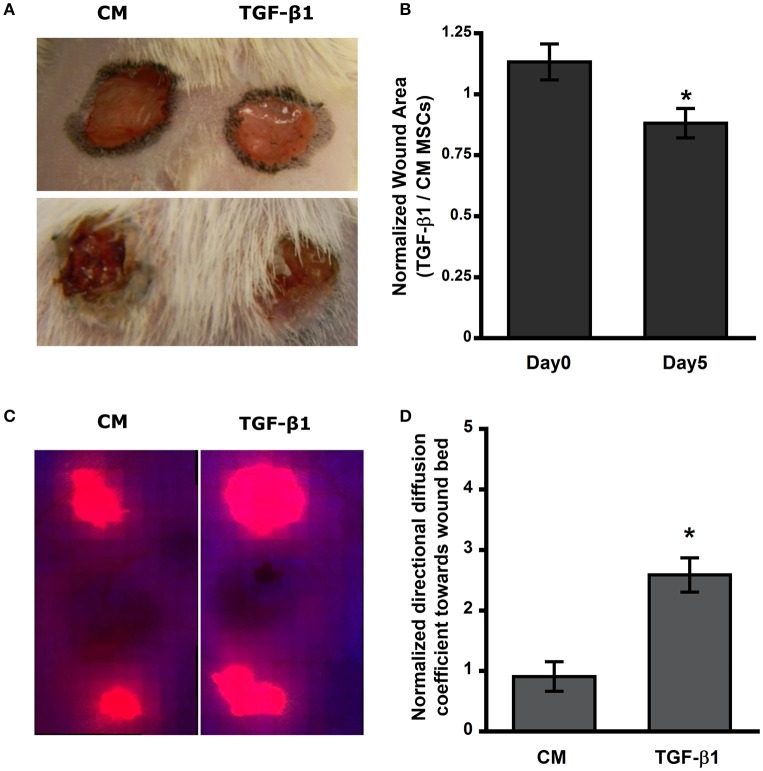
Transforming growth factor–β1 (TGF-β1) pretreated mesenchymal stem cells (MSCs) migrate and distribute efficiently in the wound bed and improve wound closure rate in Balb/C mice. (A) Full thickness skin wound on Balb/C mice at day 0 and 5. (B) Open area of TGF-β1 pretreated MSCs injected wound normalized to its respective control. (C) Thresholded fluorescence images of skin tissue showed enhanced distribution of MSCs toward center of the wound. (D) Quantification of directed distribution of MSCs toward the center of the wound (n = 3). Values given as mean ± s.e.m.; significance is indicated as *(p < 0.05).